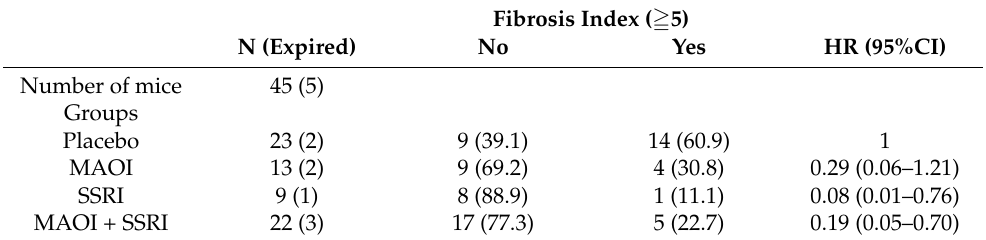
Table 3. Hazard ratio for oral submucous fibrosis occurrence in different treatment groups compared with placebo